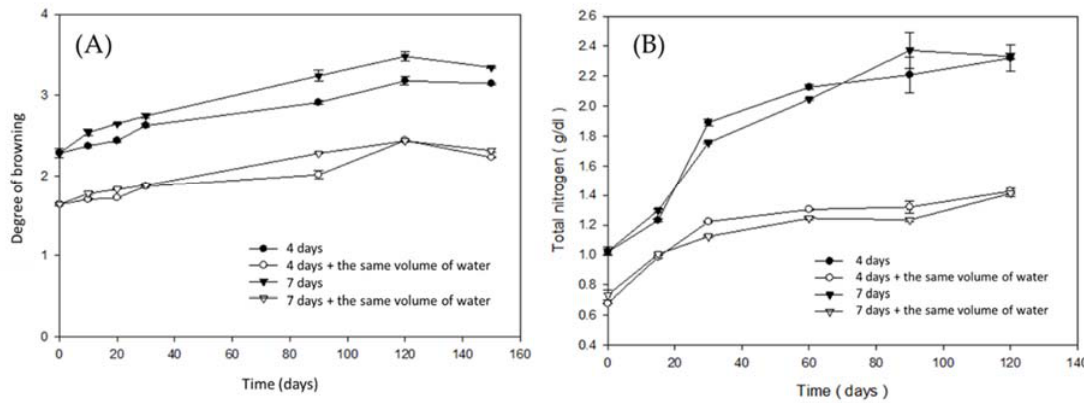
Figure 2. Changes in ( A ) browning during the brewing period of fish sauce of each group; ( B ) total nitrogen during the brewing period of fish sauce of each group (— ● —: Group A; — ○ —: Group B; — ▼ —: Group C; — △ —: Group D).